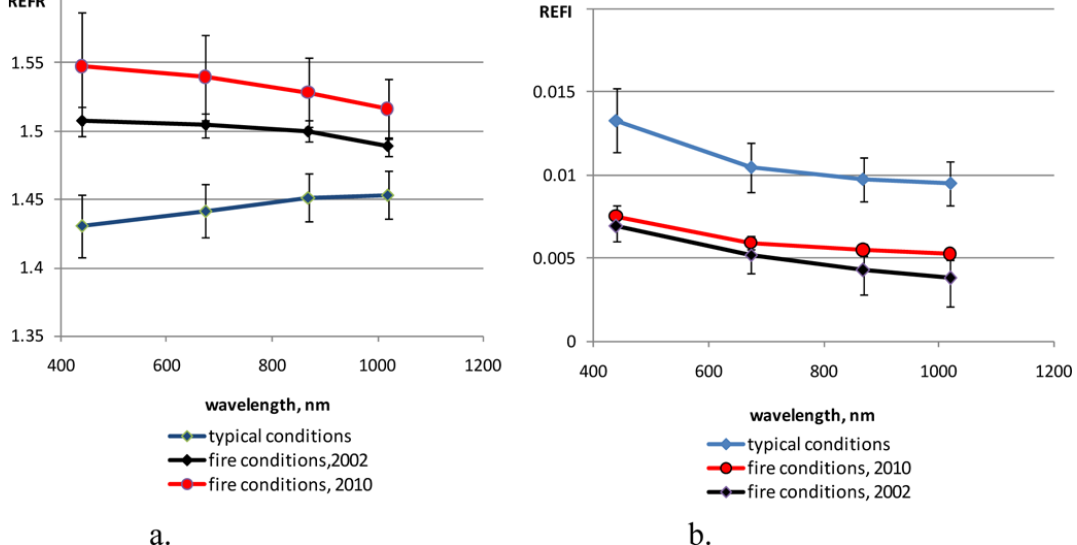
Fig. 8. Spectral dependence of real REFR (a) and imaginary REFI (b) part of refractive index in typical conditions (blue color) without fires during 2001–2010 and during forest fires events 2002 ( n = 63, shown in black), and 2010 ( n = 7, shown in red) with error bars at 95% confidence level.